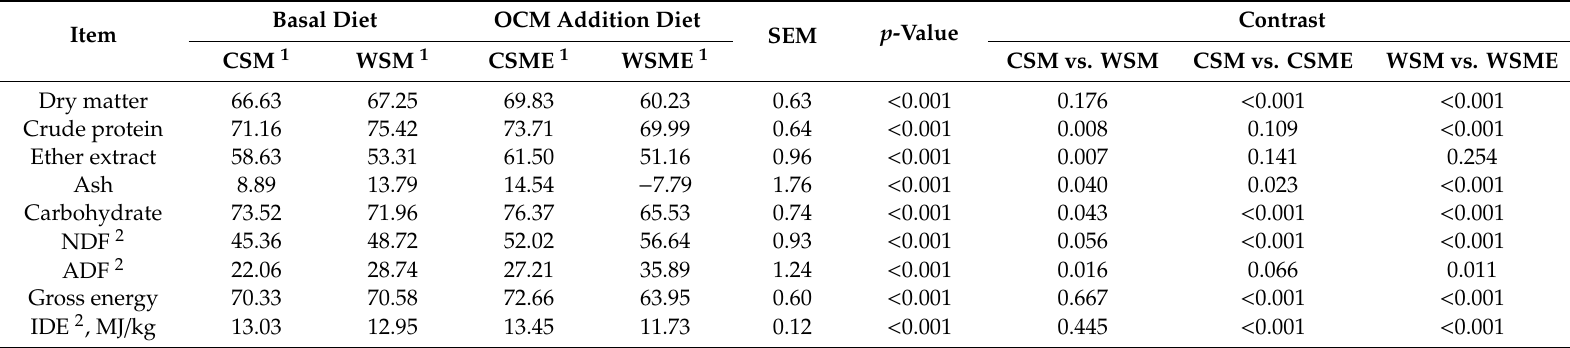
Table 4. E ff ects of the optimal carbohydrase mixtures on apparent ileal digestibility of nutrients and energy in growing pigs fed two types of diets, %. Item